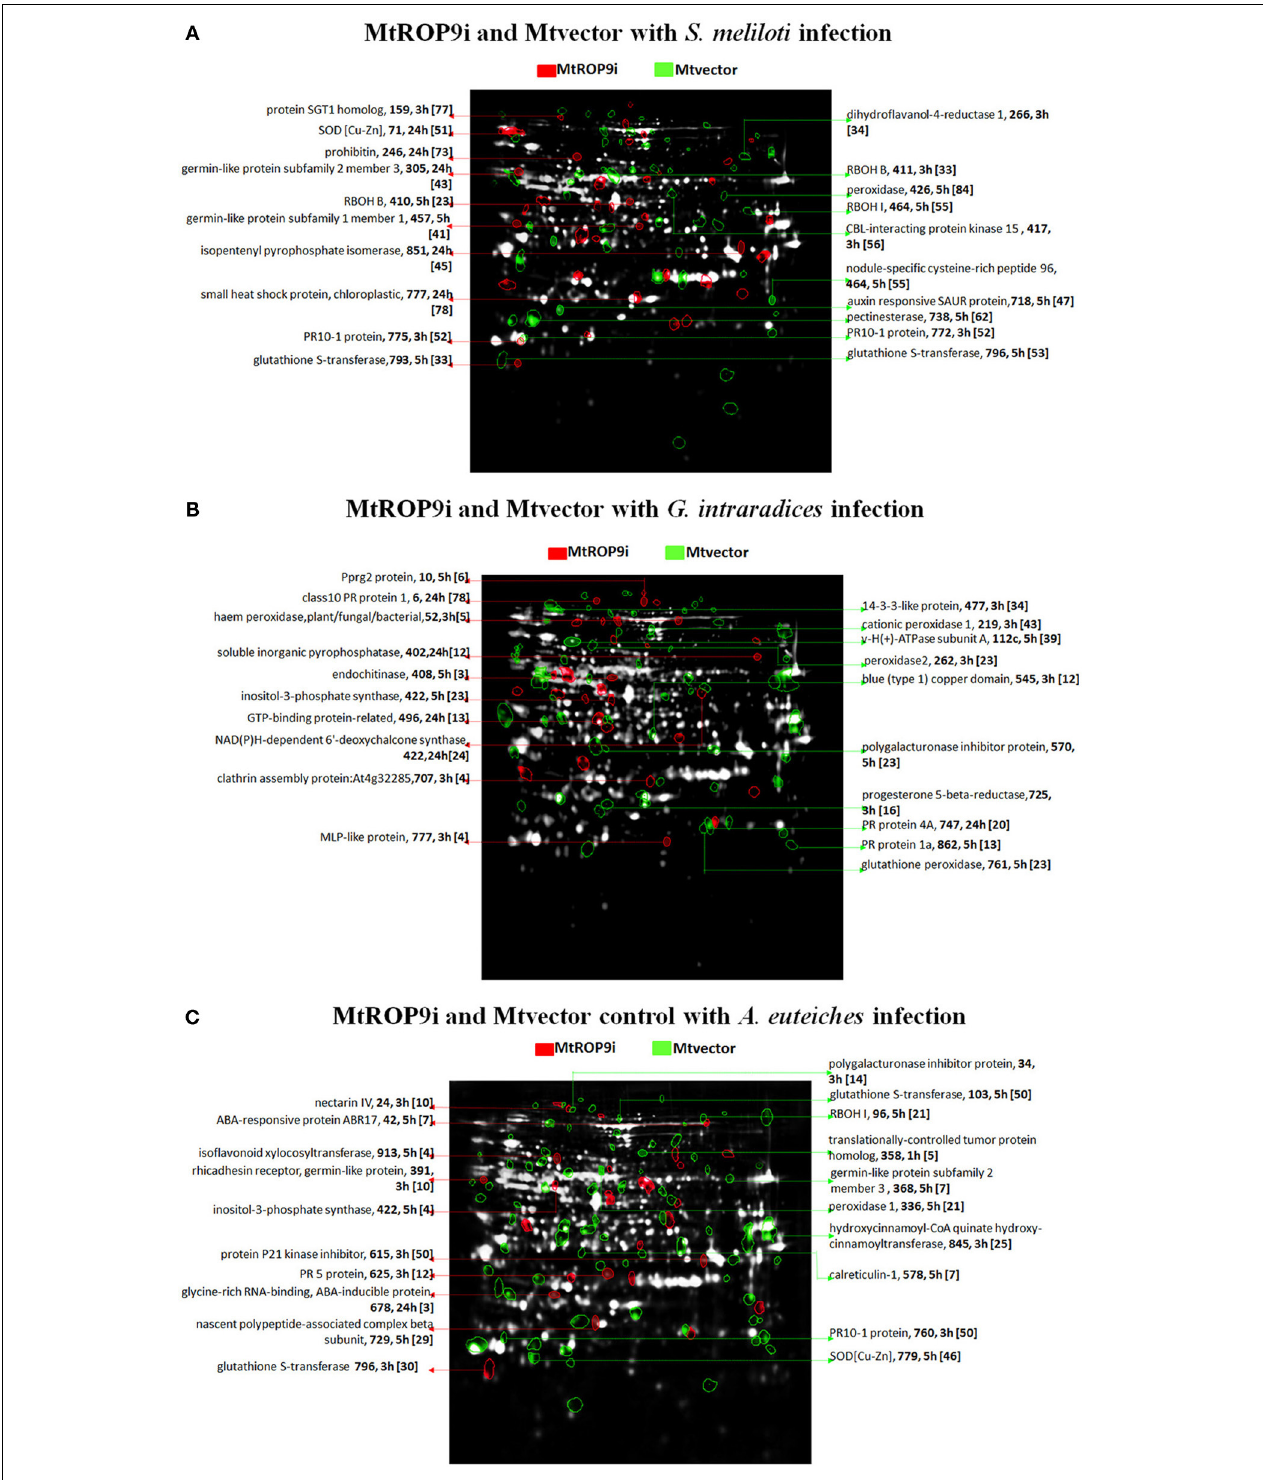
FIGURE 1 | Proteins of high abundance in MtROP9i (red spots) and Mtvector (green spots) after S. meliloti (A), G. intraradices (B) and A. euteiches (C) infections for the predominant physiological categories defense response, stress response, signal transduction, secondary